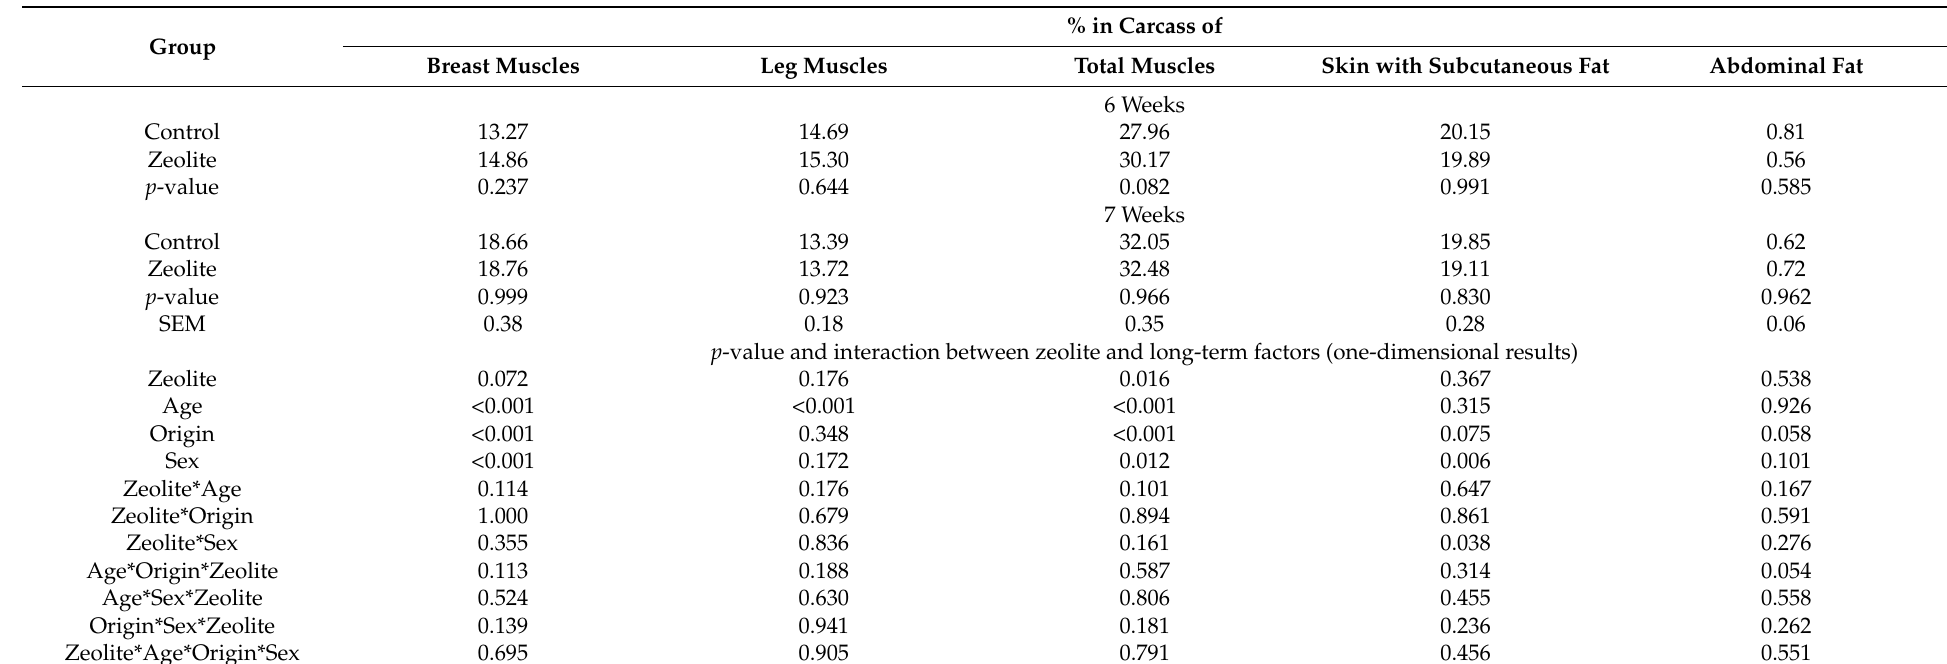
Table 5. Muscle and fat content in broiler ducks carcasses